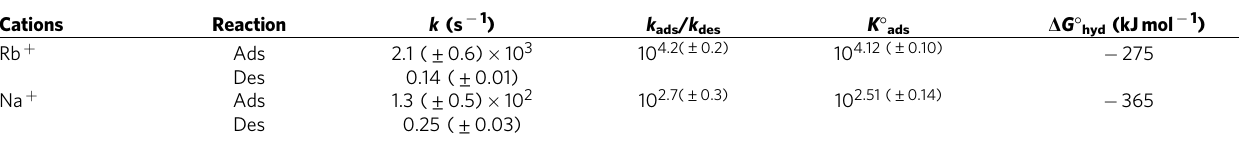
Table 1 | Kinetic and thermodynamic properties of adsorption and desorption of Rb þ and Na þ at the muscovite mica (001)– water interface at 25 (cid:2) C.